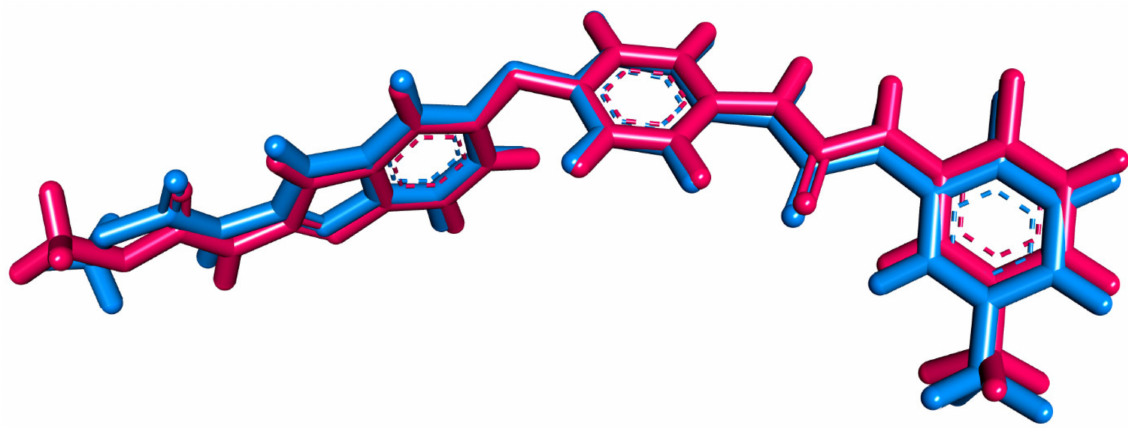
Figure 3. An inhibitor was docked into the active site of VEGFR-2.